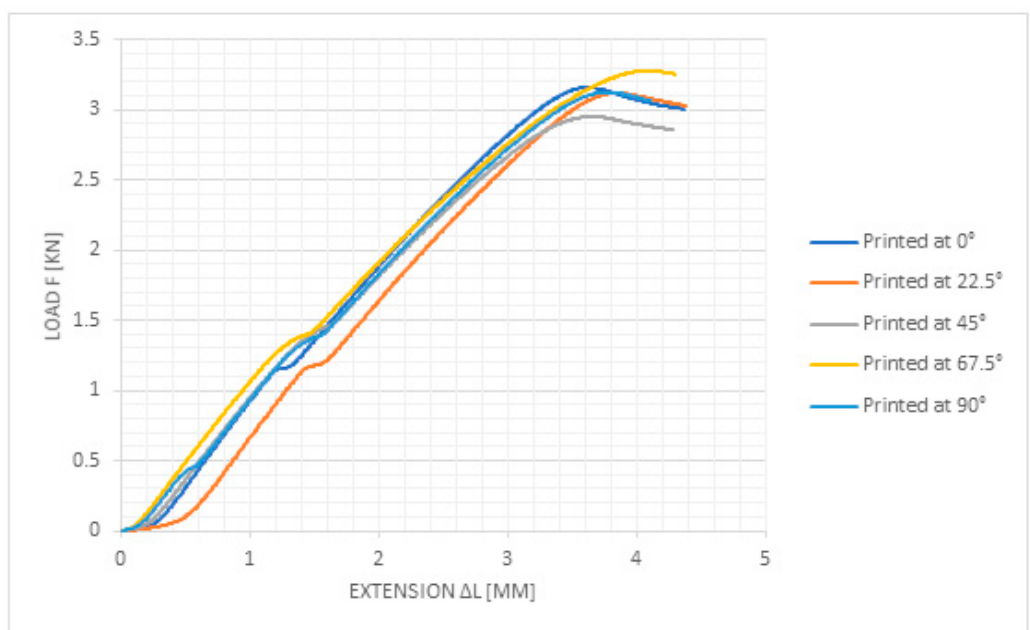
Figure 13. Examples of individual waveforms of PLA material printed with different orientations.